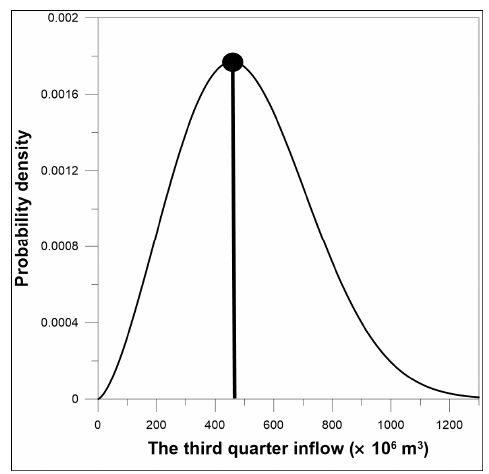
Figure 1. An example of probability density function of the third quarter inflow conditioned on the second quarter inflow of 100 × 10 6 m 3 .